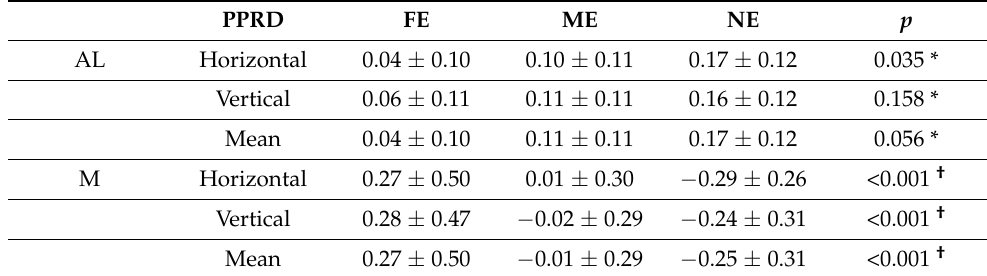
Table 3. Changes of AL and refractive outcome (M) from baseline to 12-months treatment in the PPRD group: no effect (NE, n = 23) of the PPRD on the pupil (a pupillary diameter <PPRD − 0.9 mm), medium effect (ME, n = 40) of the PPRD on the pupil (the pupil settled into the span of the PPRD ± 0.9 mm), and full effect (FE, n = 8) of the PPRD on the pupil when the pupilexceeded PPRD + 0.9